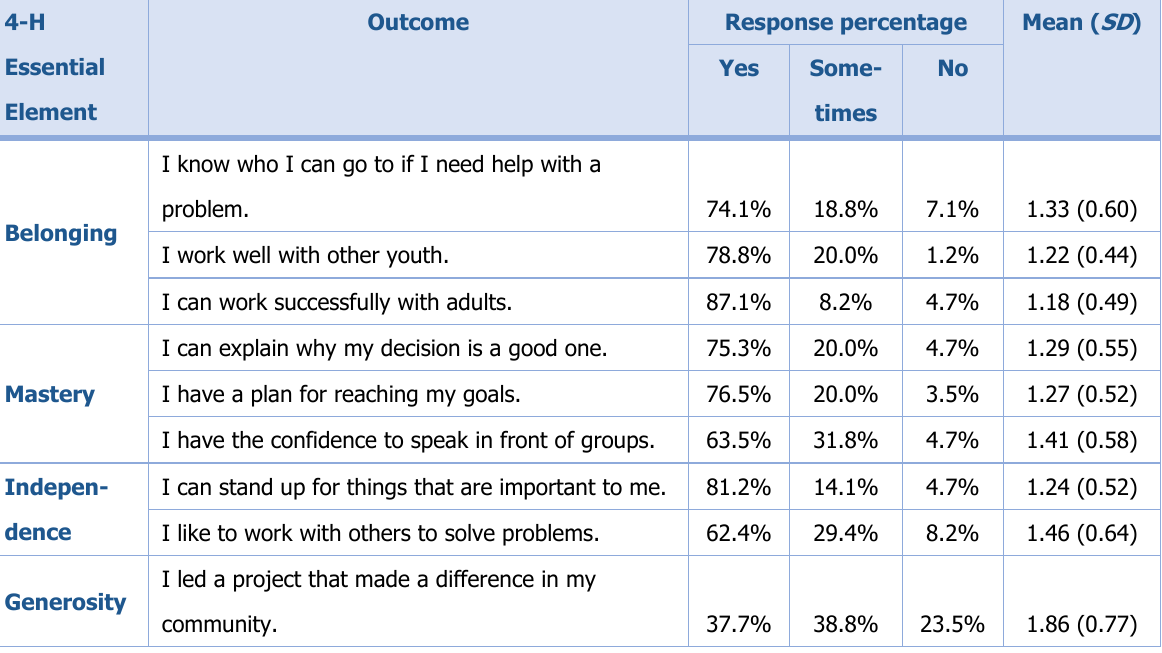
Table 1. Youth Outcome Responses and